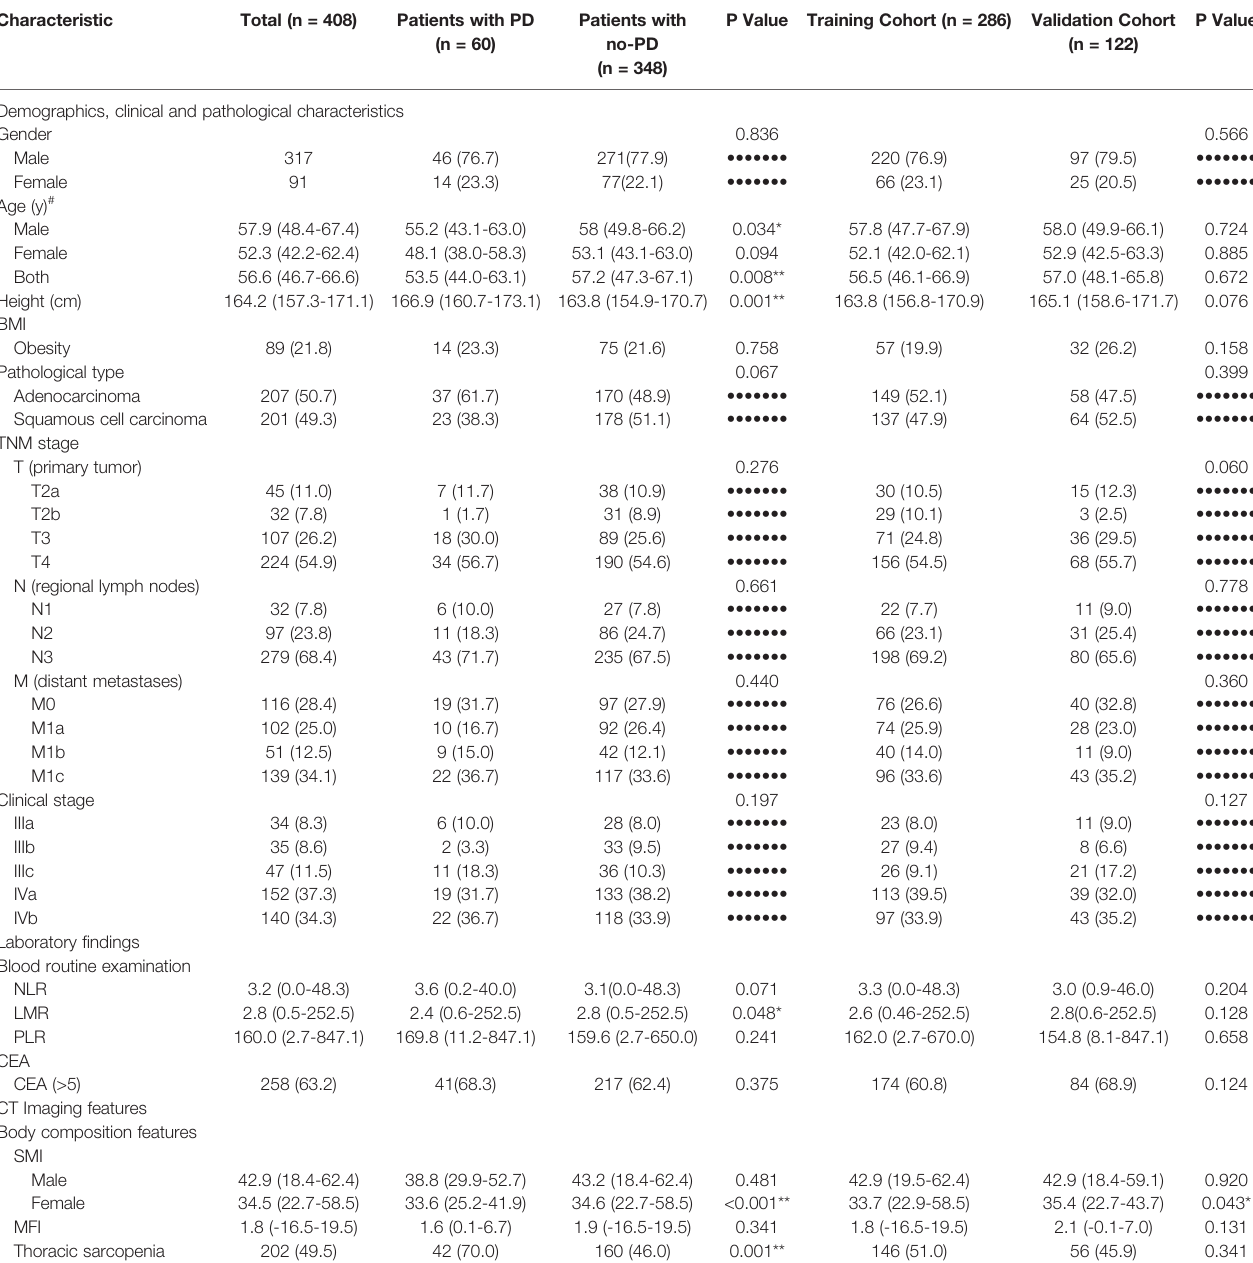
TABLE 1 | Demographic, clinicopathological, and CT body composition features of patients with advanced non-small cell lung cancer. Characteristic